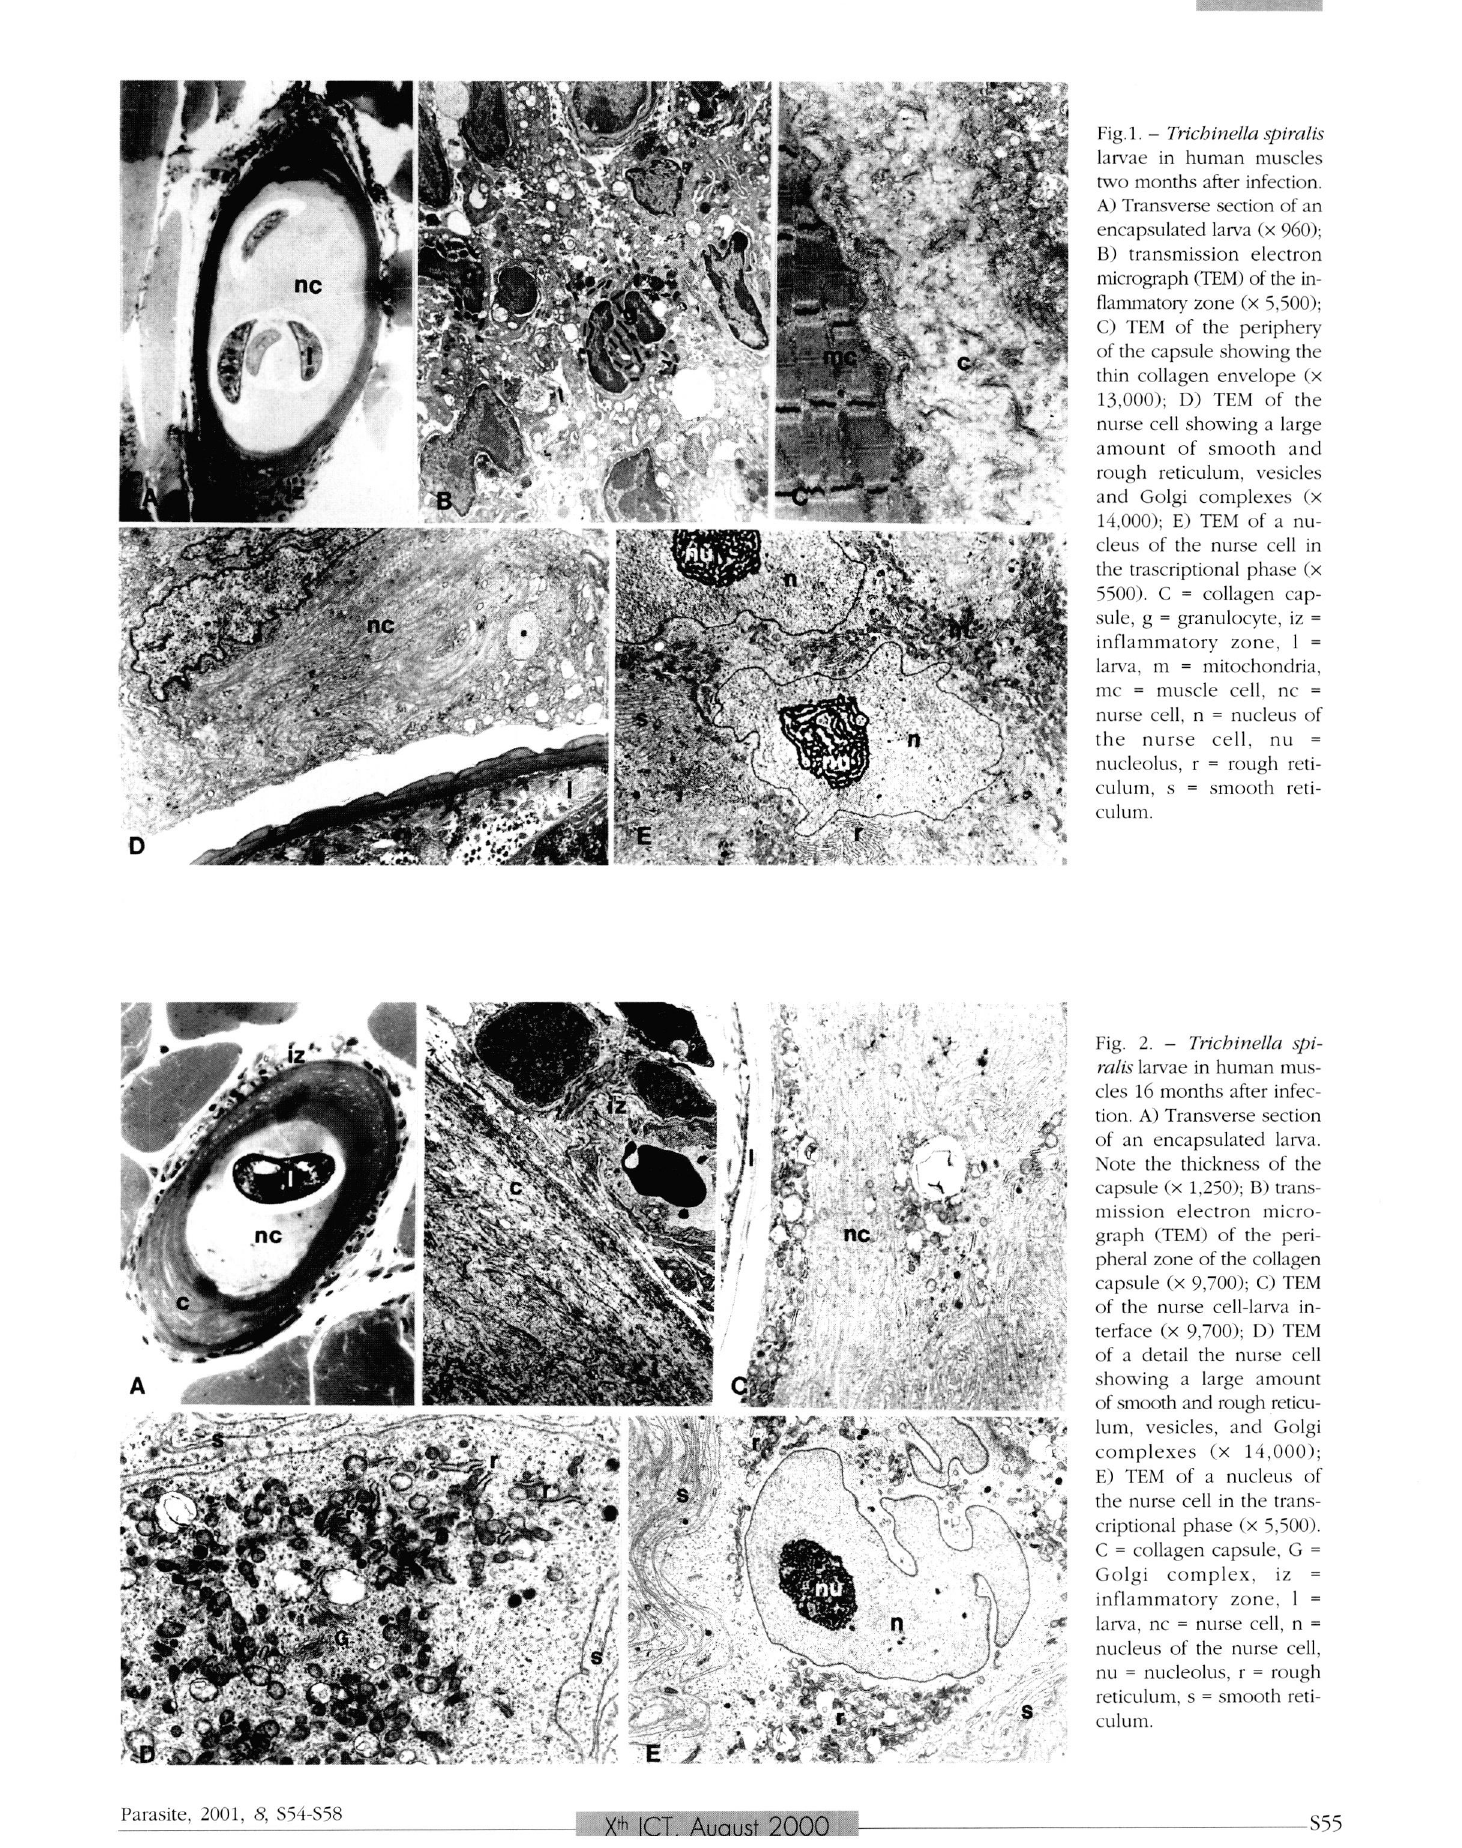
Fig. 1. - Trichinella spiralis larvae in human muscles two months after infection. A) Transverse section of an encapsulated larva (x 960); B) transmission electron micrograph (TEM) of the in­ flammatory zone (x 5,500); C) TEM of the periphery of the capsule showing the thin collagen envelope (x 13,000); D) TEM of the nurse cell showing a large amount of smooth and rough reticulum, vesicles and Golgi complexes (x 14,000); E) TEM of a nu­ cleus of the nurse cell in the trascriptional phase (x 5500). C = collagen cap­ sule, g = granulocyte, iz = inflammatory zone, 1 = larva, m = mitochondria, mc = muscle cell, nc = nurse cell, n = nucleus of the nurse cell, nu = nucleolus, r = rough reti­ culum, s = smooth reti­ culum.